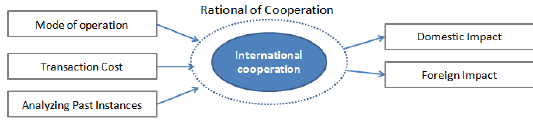
Fig. 1. Block Diagram of International Space cooperation